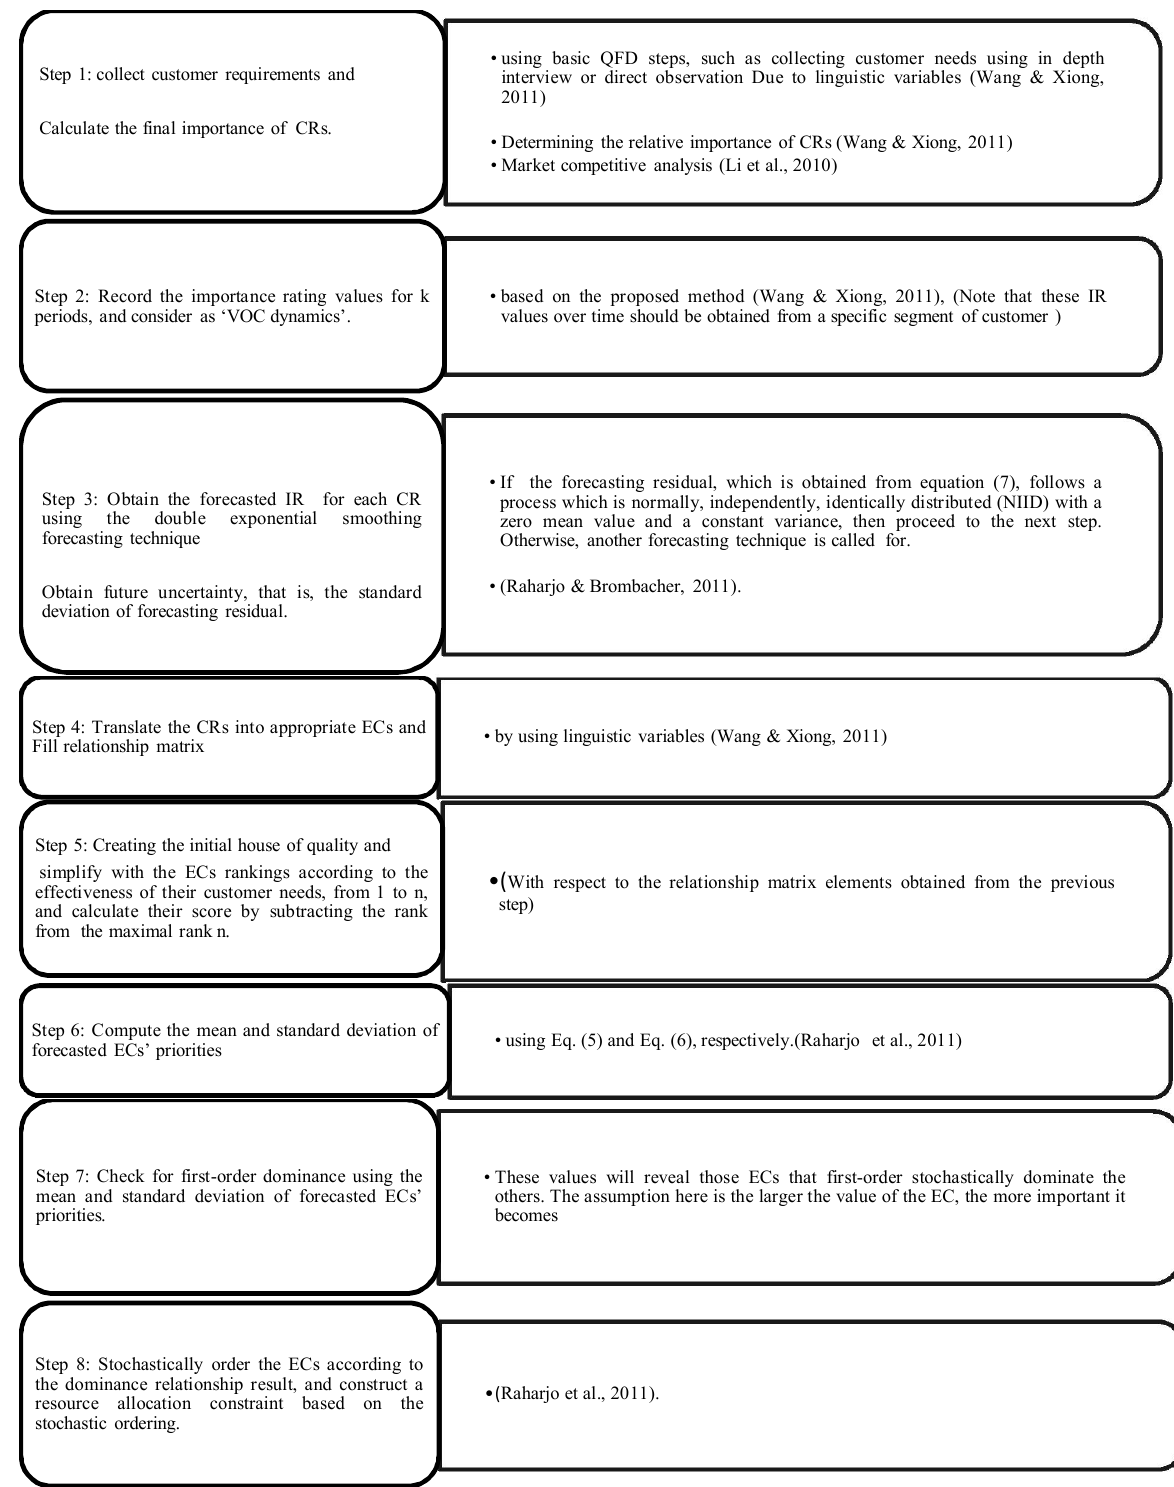
Fig. 5. The proposed